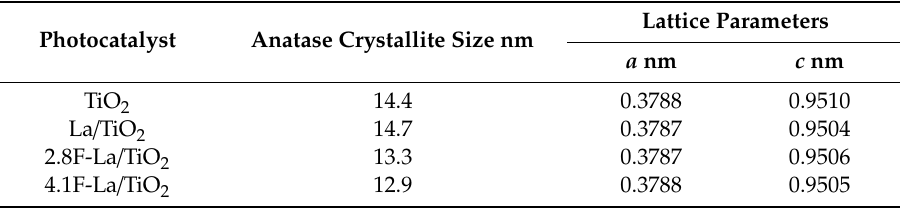
Table 2. Structural and microstructural properties of investigated photocatalysts.